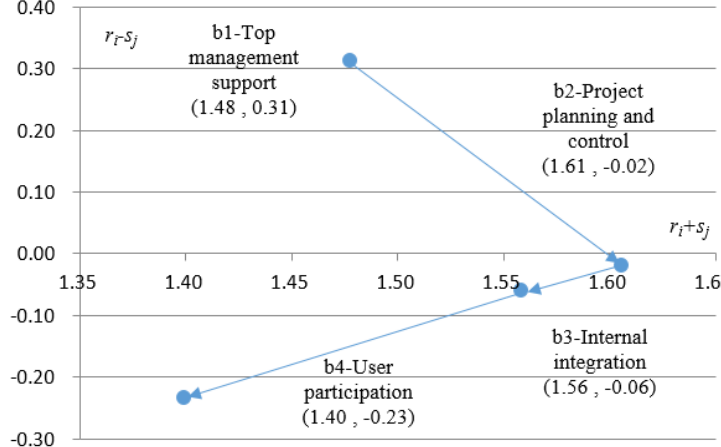
Figure 5. Dimension B–criterion of IRM.